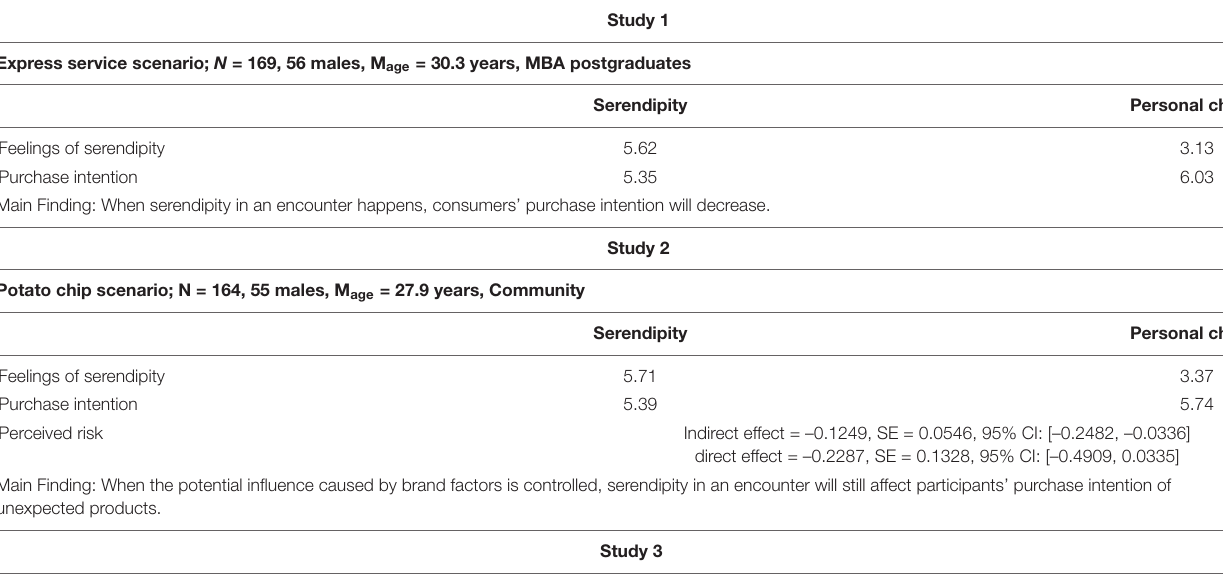
TABLE 1 | Summary of results of by study